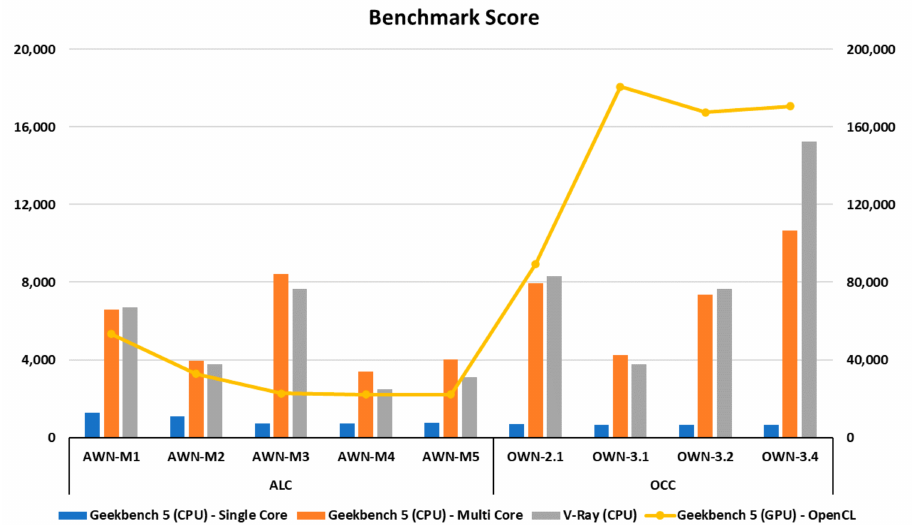
Figure 2. Results of the benchmark test using GeekBench 5 and V-Ray to measure the power of the CPU and GPU for each single-node in the ALC and OCC. The higher scores indicate better